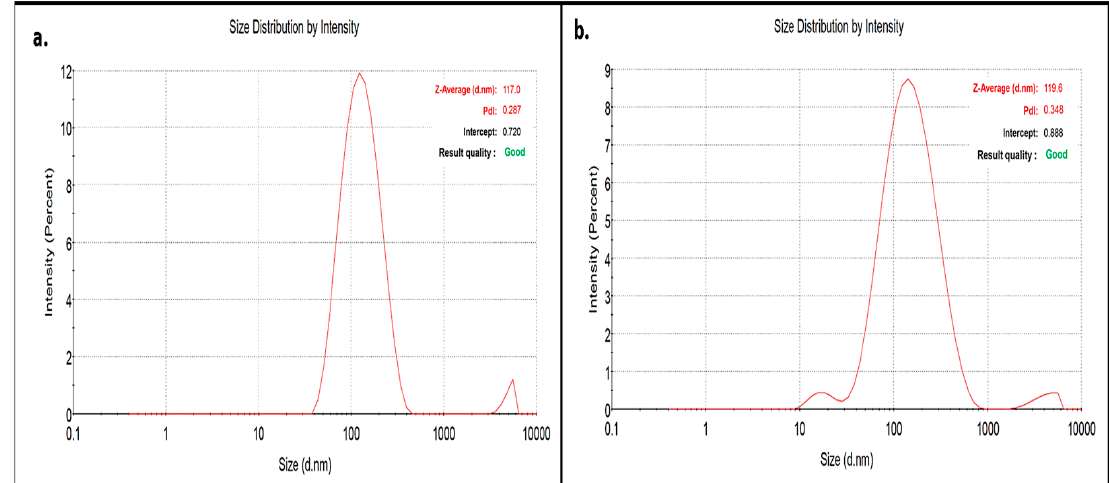
Figure 3. Size distribution vs intensity plot of ( a ) CX-AuNPs ( b ) CT-AuNPs. Scanning Electron Microscopy (SEM) scans the nanomaterial surface with a focused beam of high-energy electrons. The electron beam interacts with the nanomaterial to create signals that could be further translated into information pertinent to the surface morphology of the nanomaterial [53]. Here, in the present investigation, SEM was used to observe the surface morphology of the synthesized CX-AuNPs and CT-AuNPs, and both the AuNPs appeared spherical in shape (Figure 4). These findings were in accordance with the previous investigations, where antibiotics were loaded/conjugated to AuNPs and a similar spherical shape pattern was observed [15,19,46].